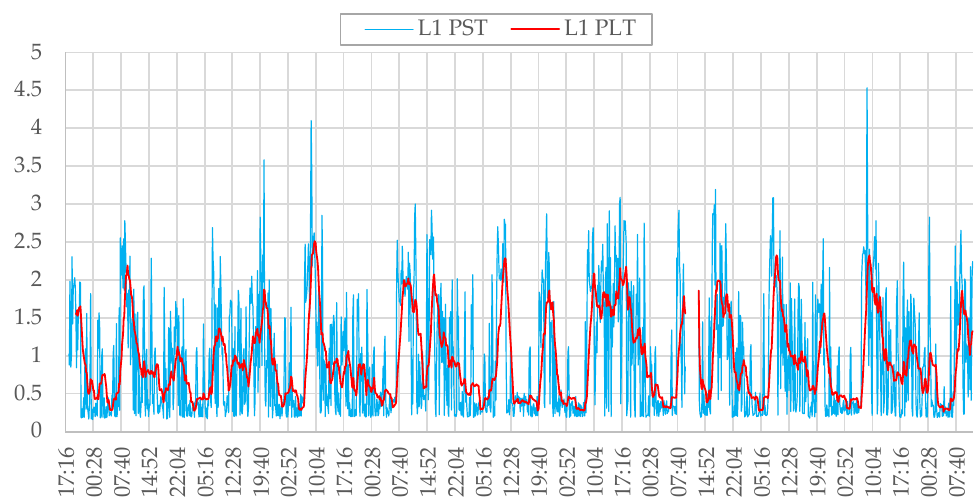
Figure 12. Flicker values for Object 2 in phase L1, according to standard EN 50160 – PST in 10-min intervals and PLT in 2-h average intervals (allowed limit <1.0 95% of the time).